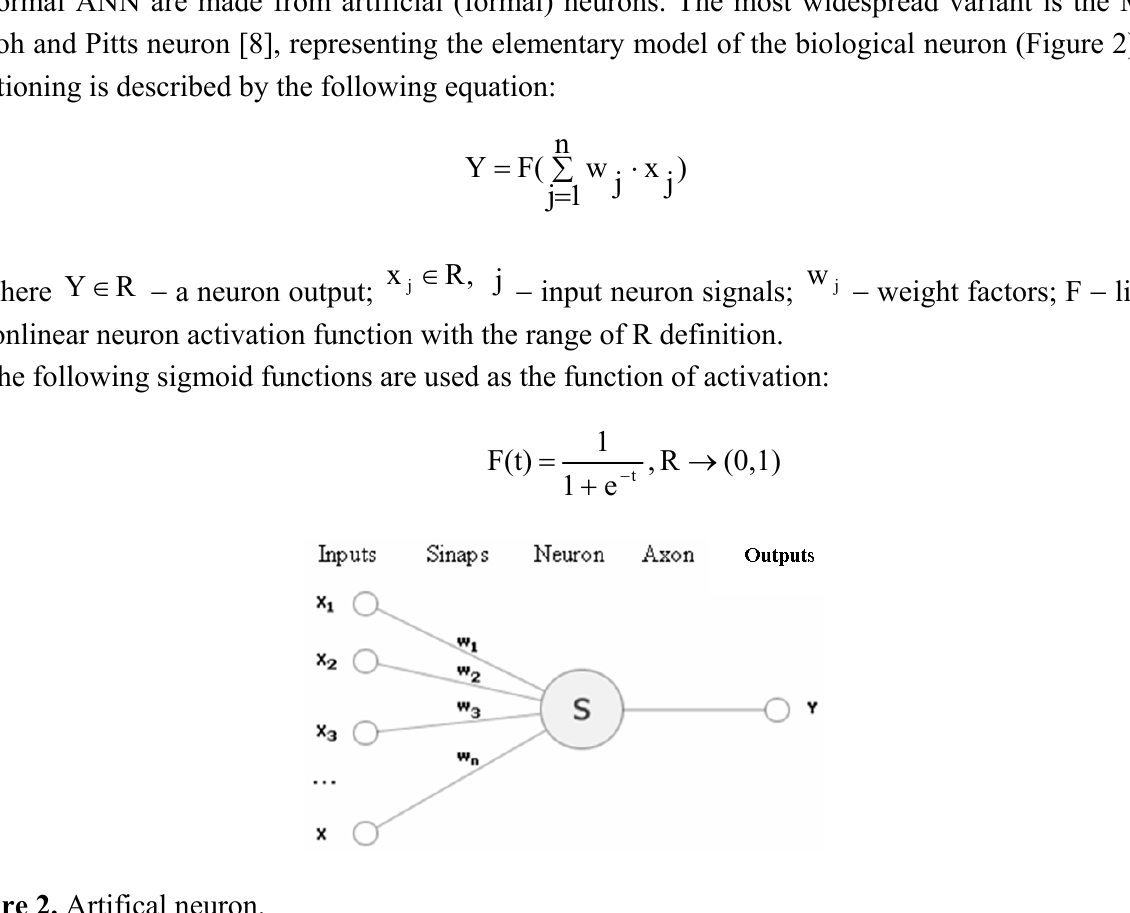
Figure 2. Artifical